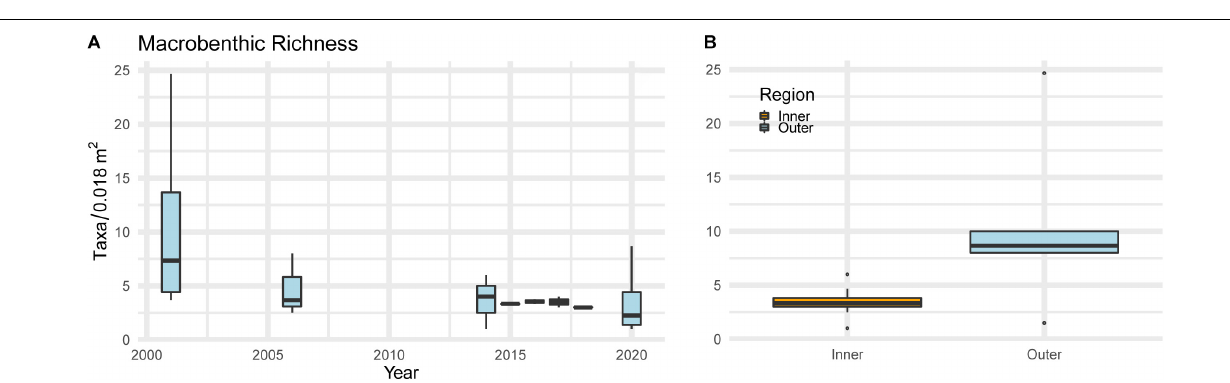
2020. Demographic data show that the human population has continuously increased in the nine municipalities around the bay ( Figure 3C